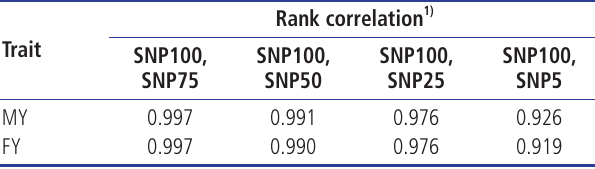
Table 6. Spearman rank correlations between SNP100 and SNP75, SNP100 and SNP50, SNP100 and SNP25, and SNP100 and SNP5 for MY and FY Rank correlation Trait